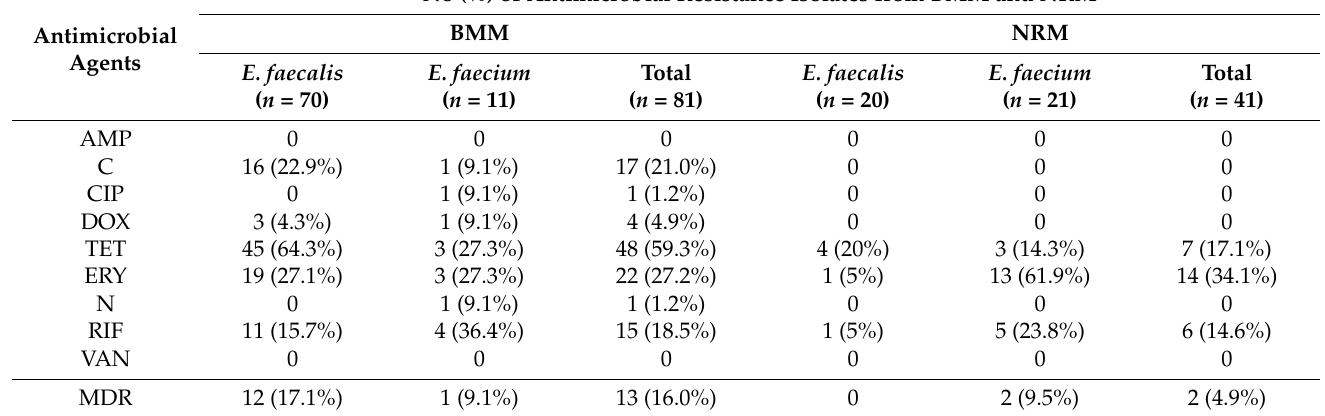
Table 3. Antimicrobial resistance of Enterococcus faecalis and Enterococcus faecium isolates from bovine mastitis milk (BMM) and bovine normal raw milk